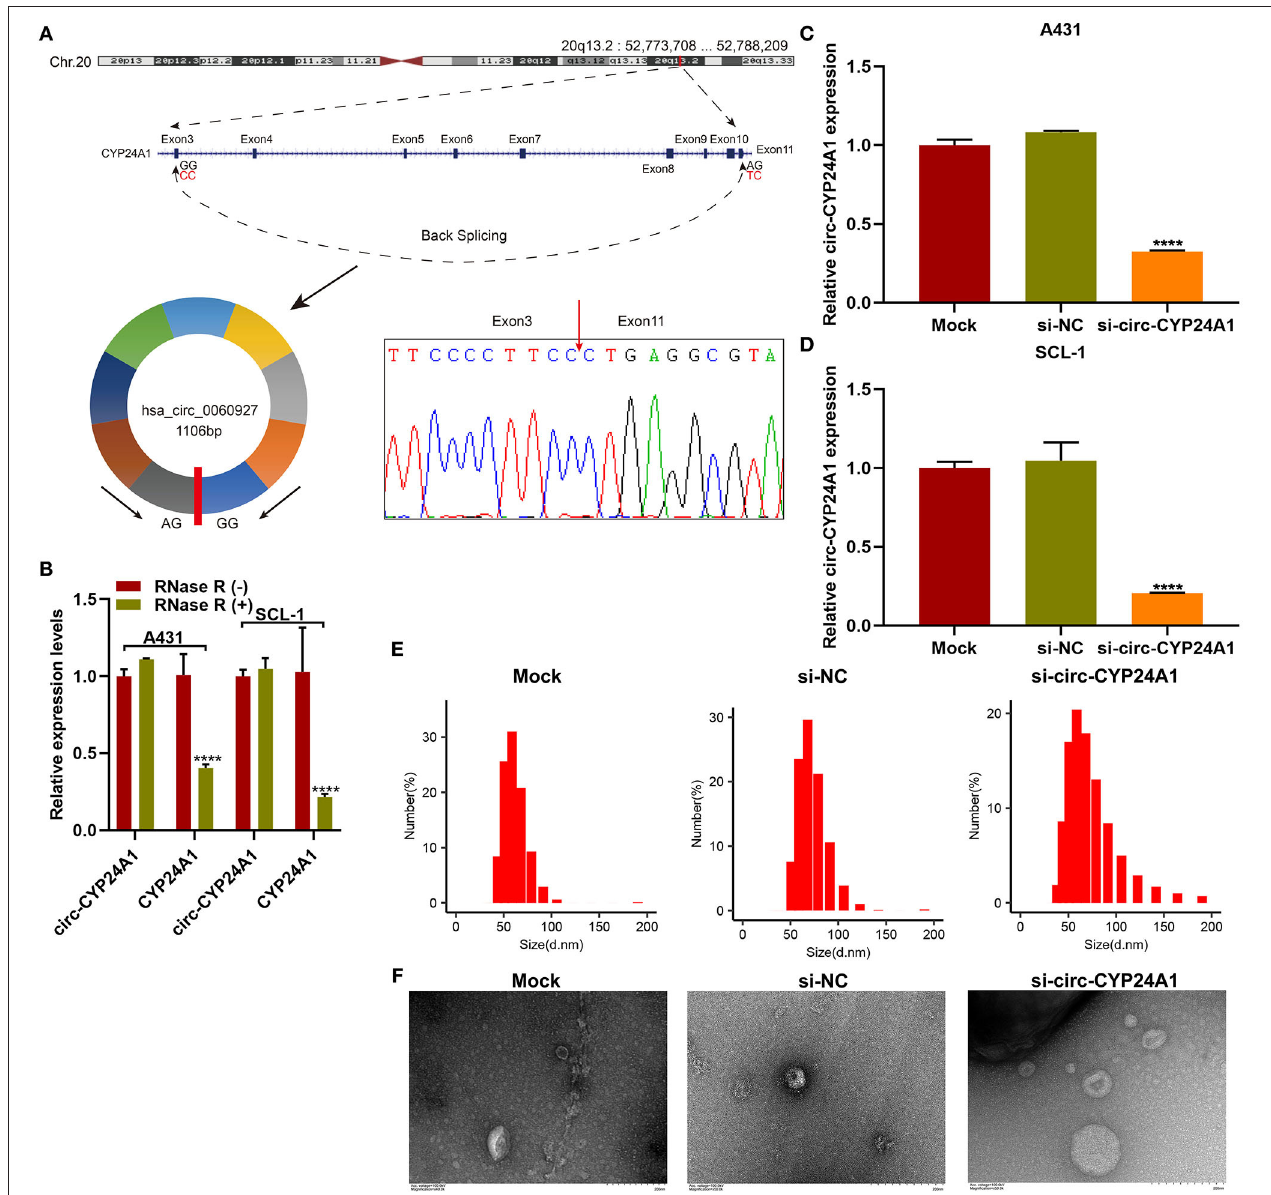
FIGURE 5 | Validation of the biological structure of circ-CYP24A1. (A) Sanger sequencing for the circ-CYP24A1 PCR products. (B) RT-qPCR for the expression of circ-CYP24A1 in A431 and SCL-1 cells under RNase R (-) or RNase R ( + ). (C,D) RT-qPCR confirming the expression of circ-CYP24A1 in A431 and SCL-1 cells incubated with si-circ-CYP24A1-transfected exosomes. (E) NTA for detecting the particle size of transfected exosomes. (F) TEM for the appearance of transfected exosomes. Bar = 200nm. **** P -value < 0.0001.